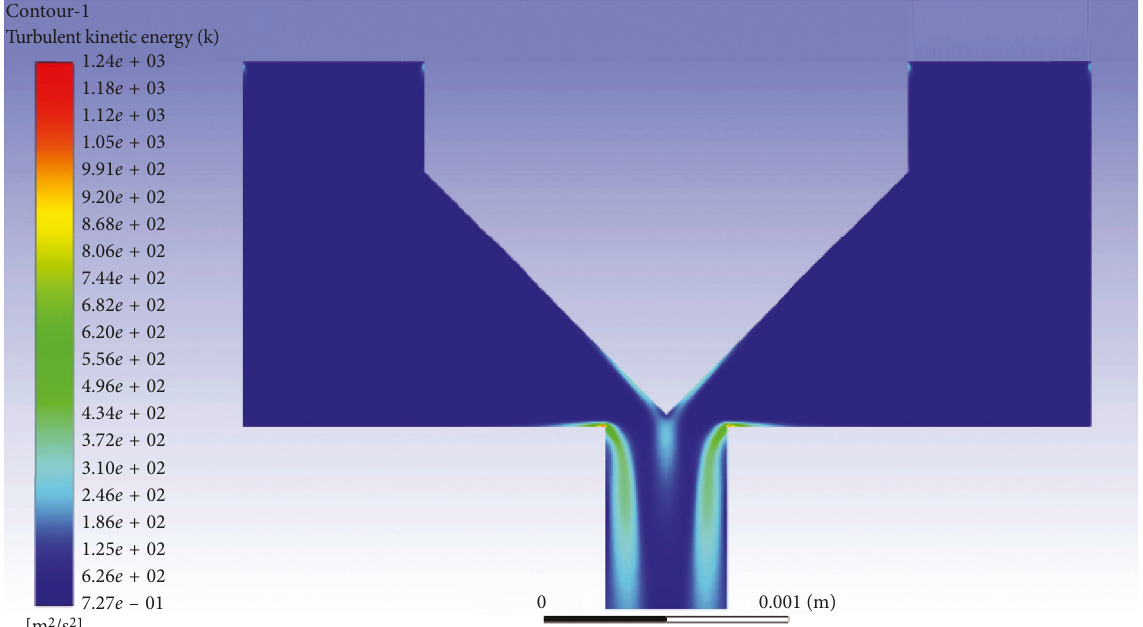
Figure 32: Turbulent kinetic energy distribution nephogram (90 ° ).